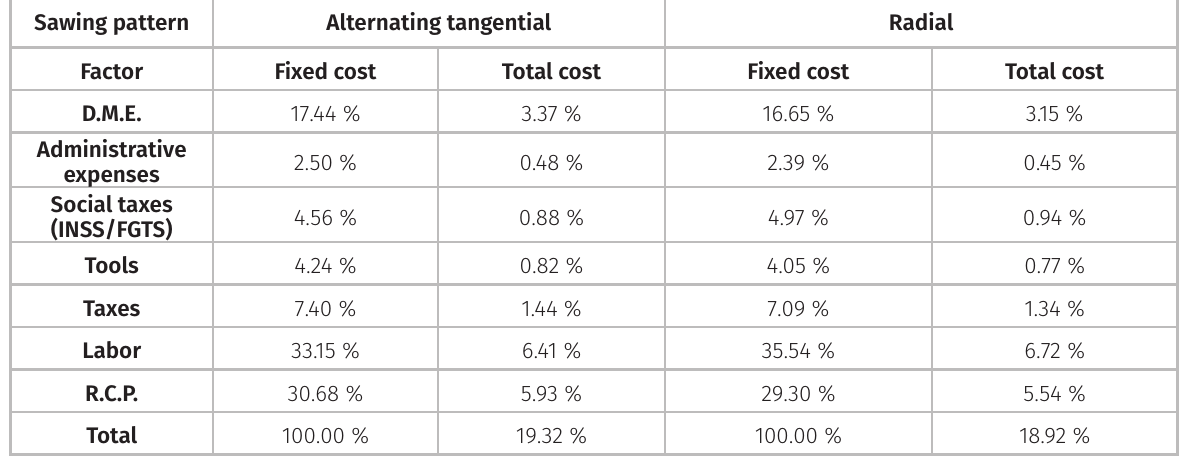
Table II. Percentage of total fix costs for the alternating sawing pattern and radial sawing pattern. Sawing pattern